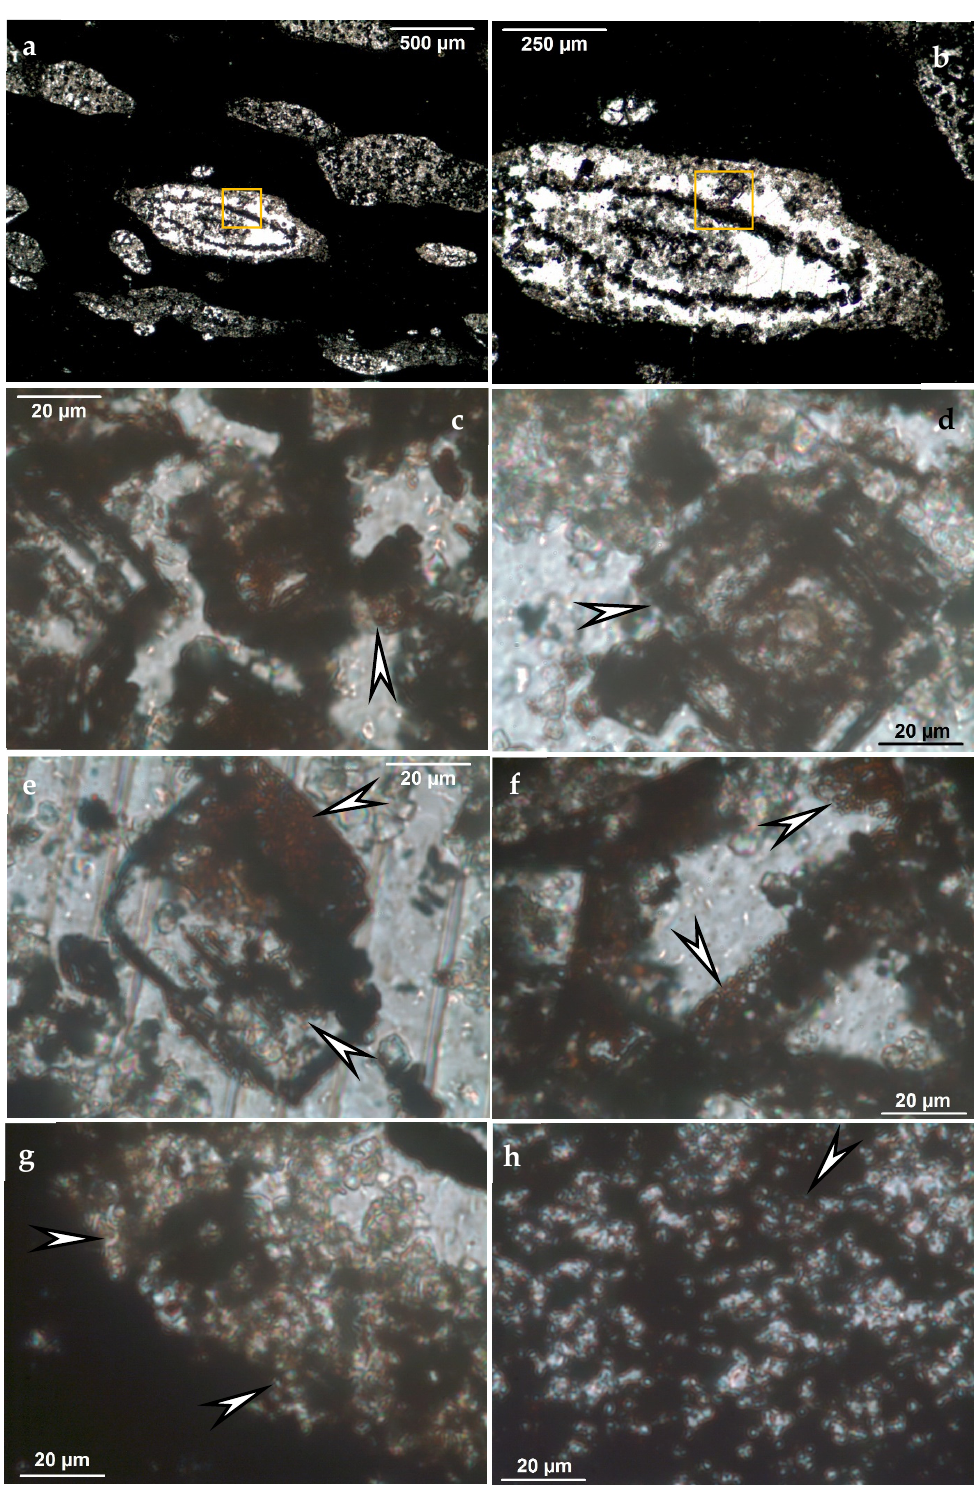
Figure 4. Mineralized microbial biosignatures shown by arrows, in Mn carbonate ore, Postmasburg- Kalahari Mesoproterozoic, drill core sample code: M15-30, provided by J. Gutzmer. ( a ) Representative texture; ( b ) enlarged area on ( a ); ( c ) representative microbial microtexture; ( d ) enlarged area on ( b ); ( e – h ) representative microbial microtexture; (photos made by optical rock microscope, transmitted light, 1 Nicol, NIKON ECLIPSE 600 rock microscope, Institute for Geology and